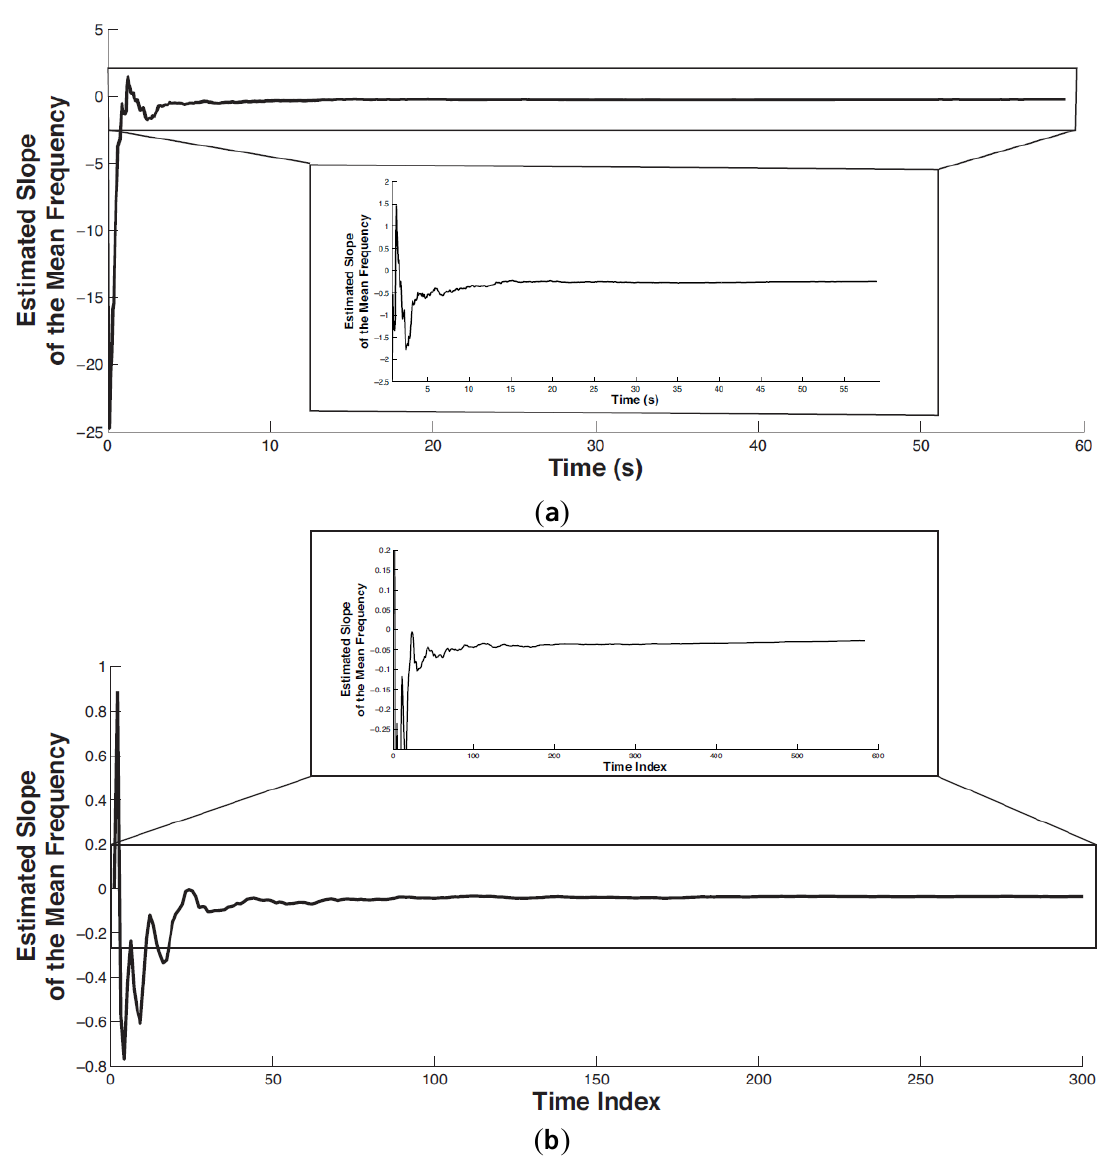
Figure 8. Tracked mean frequency trend of biceps brachii. ( a ) Experiment